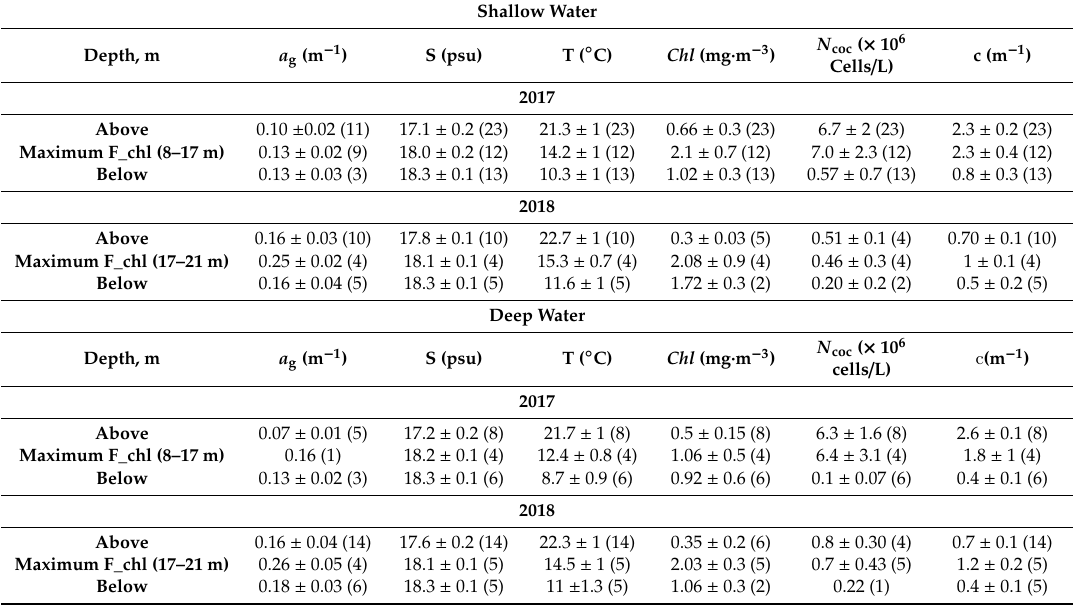
Table 2. Average values of various parameters, their standard deviations at di ff erent horizons, and the number of values for calculation (in parentheses). Chl —chlorophyll concentration; F_chl—chlorophyll fluorescence. Shallow